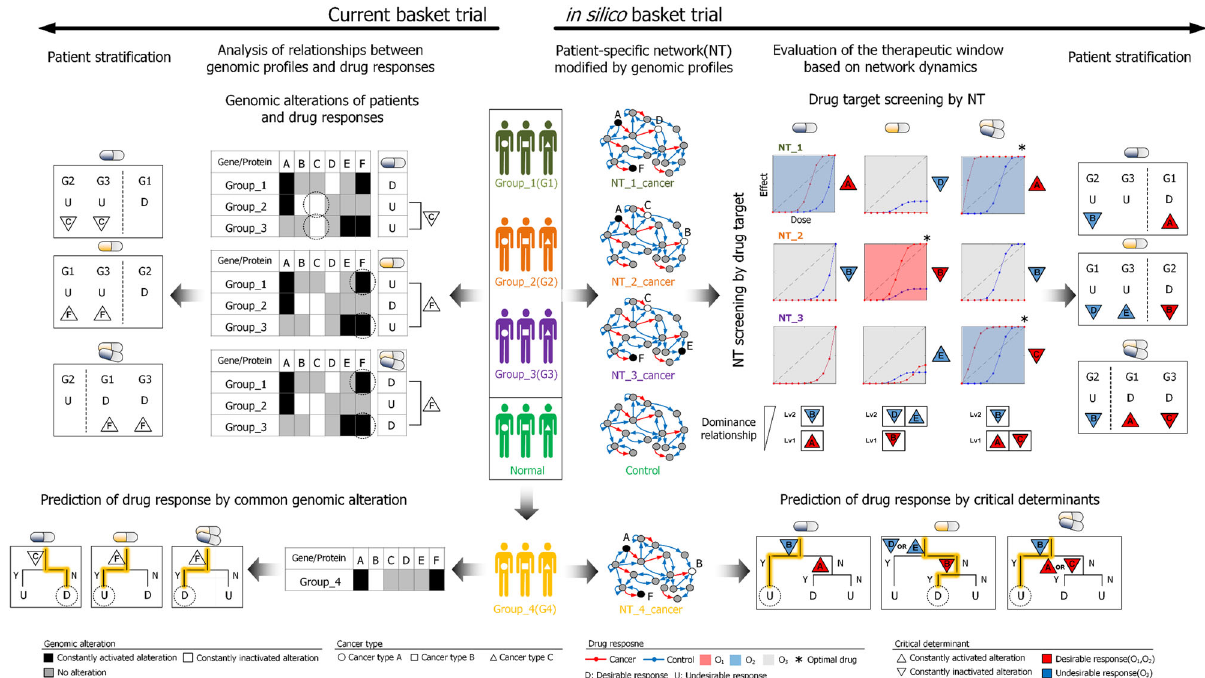
Fig. 6 Overview of network dynamics-based evaluation of the therapeutic window and strati fi cation of patients for advancing precision medicine. The patients with different cancer types are clustered into groups, G1, 2, and 3, according to their genomic pro fi les. The current basket trial analyzes relationships between the patient group ’ s genomic pro fi le and given drug responses (left). On the other hand, our in silico basket trial analyzes the dynamics of patient group-speci fi c networks, NT_1, 2, and 3 representing G1, 2, and 3, respectively, through virtual experiments (right). The two approaches lead to different drug response predictions for the new group, G4